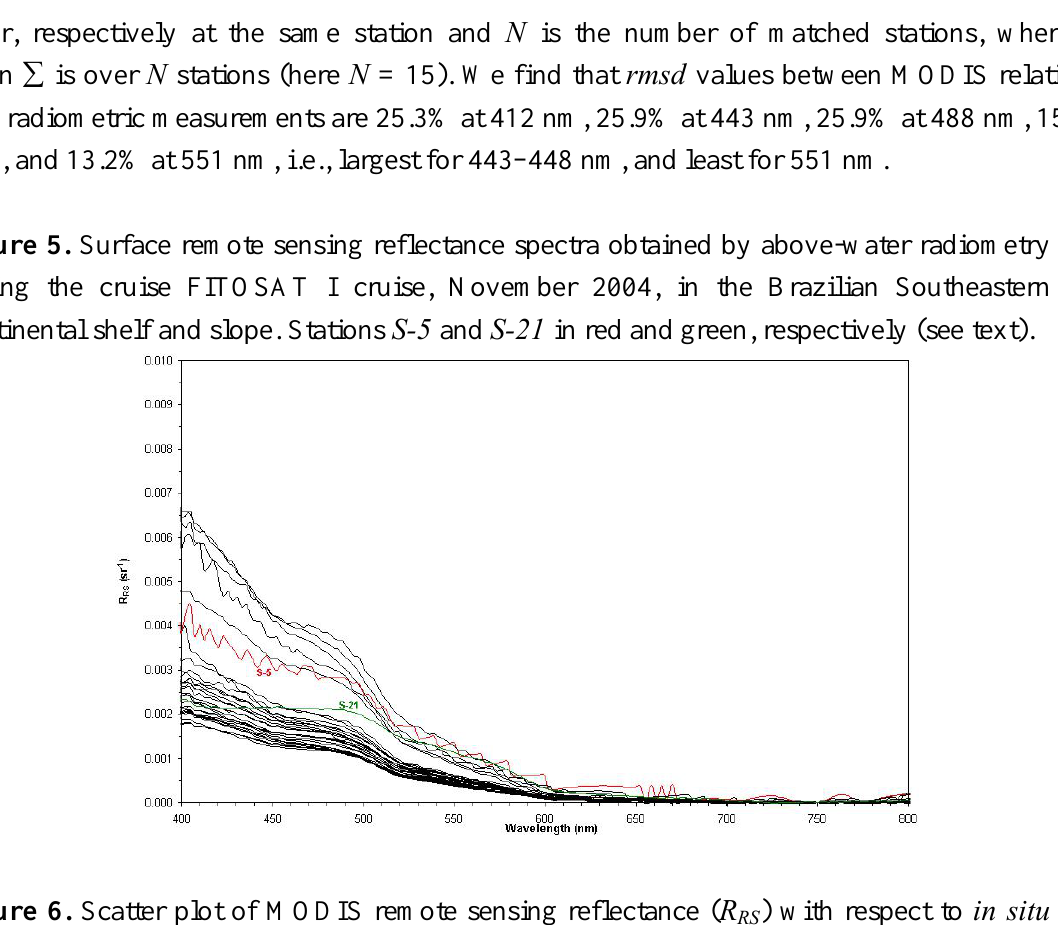
) with respect to in situ RS